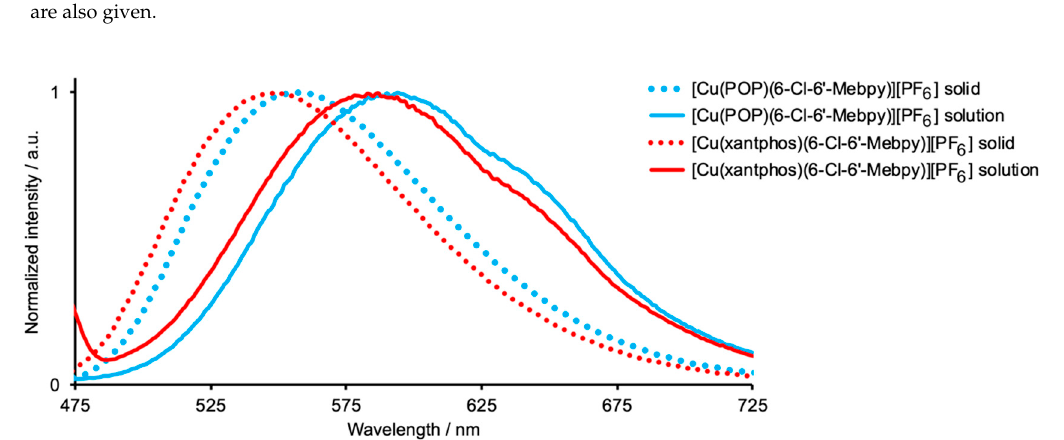
Figure 7. Emission spectra of powdered and solution (CH 2 Cl 2 , 1.0 × 10 − 5 mol dm − 3 ) samples of [Cu(POP)(6-Cl-6’-Mebpy)][PF 6 ] and [Cu(xantphos)(6-Cl-6’-Mebpy)][PF 6 ].